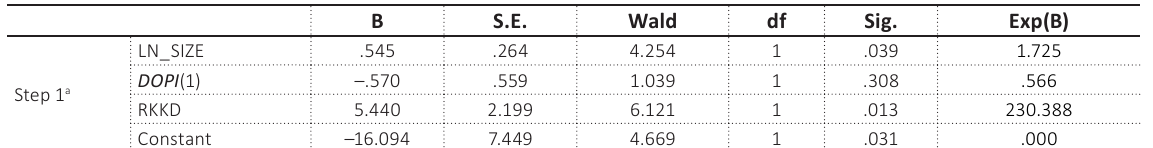
Table 10. Variables in regression equations